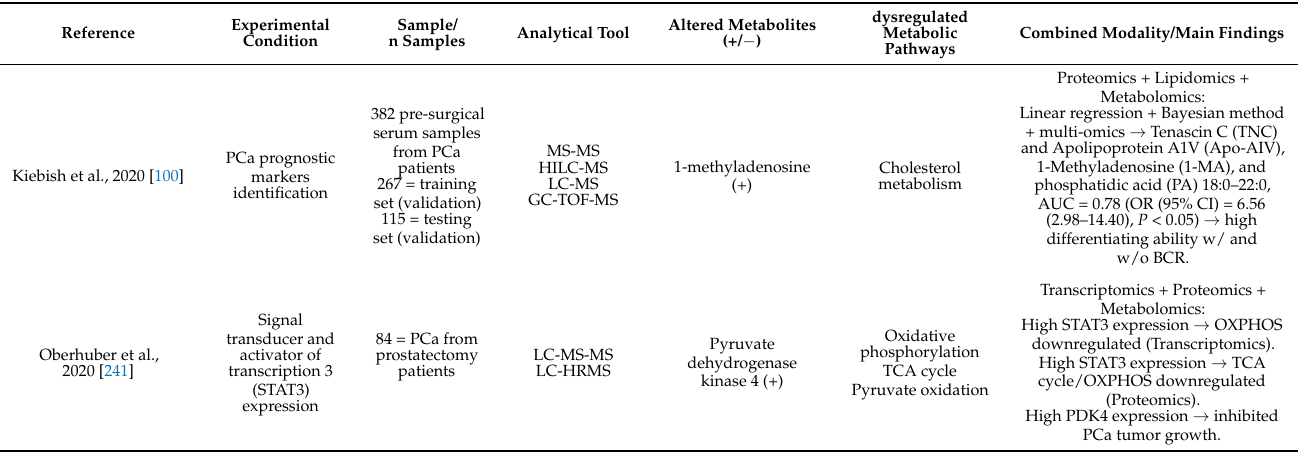
Table 4. Summary of metabolomic-based multi-omic integration studies for PCa within the last decade (2011–2021) 1,2